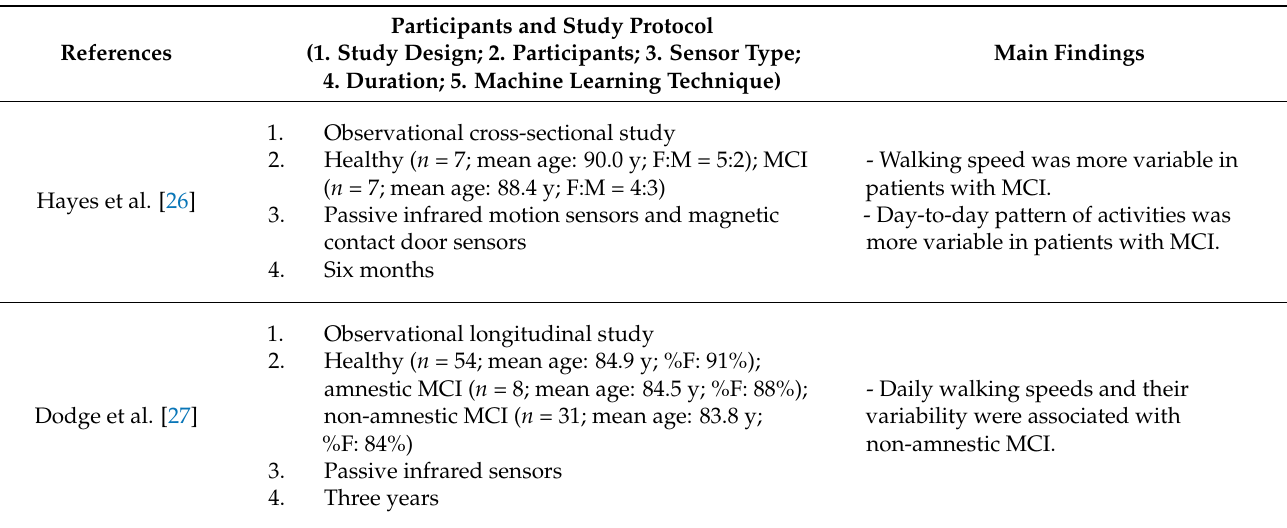
Table 3. Previous studies assessing daily behavioral patterns in patients with MCI and AD using nonwearable sensor-based in-home